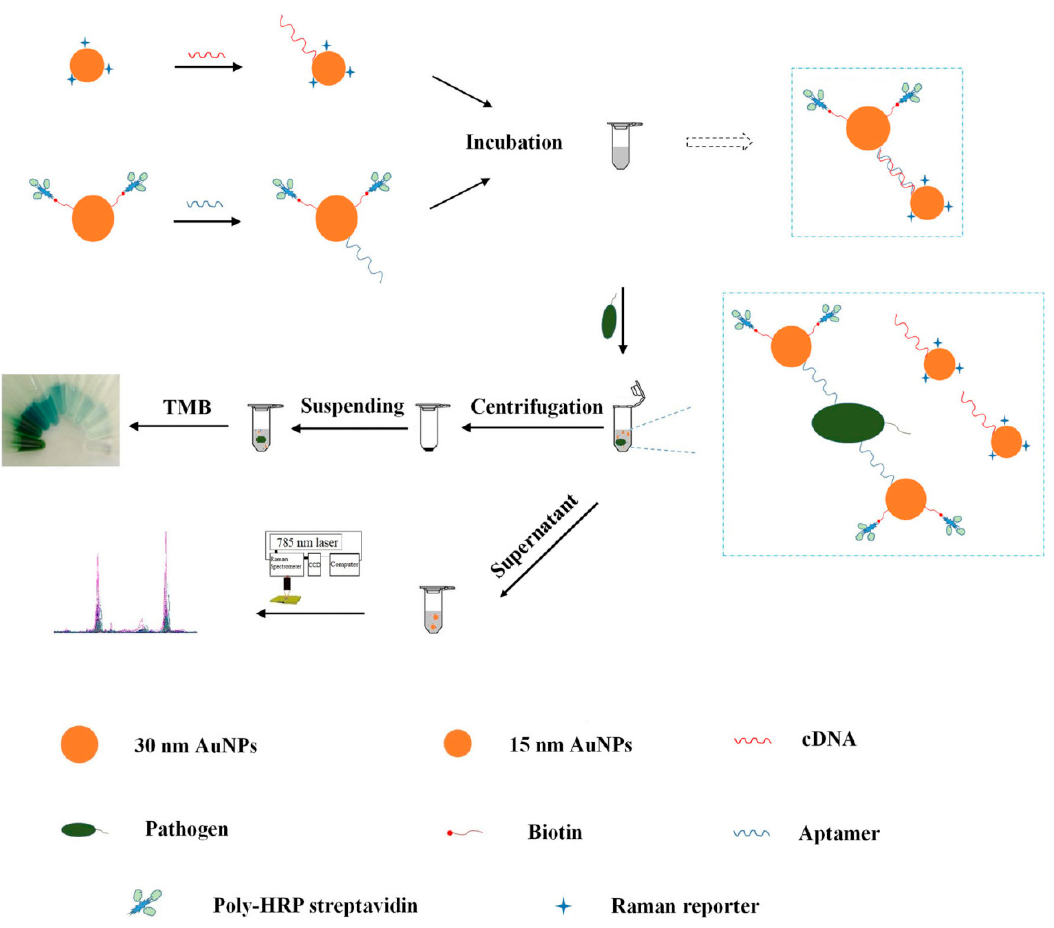
Figure 6. Schematic illustration of the fabrication procedure of the dual mode aptasensor for sensitive detection of Pseudomonas aeruginosa . (Reprinted with permission from Springer, 2018 [67]).